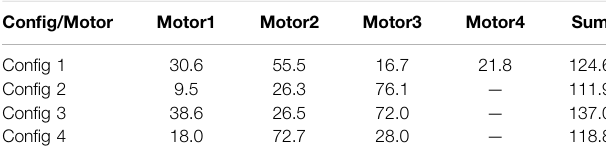
TABLE 1 | The area under Torque-Speed Curve (Total Power Requirement of each motor).